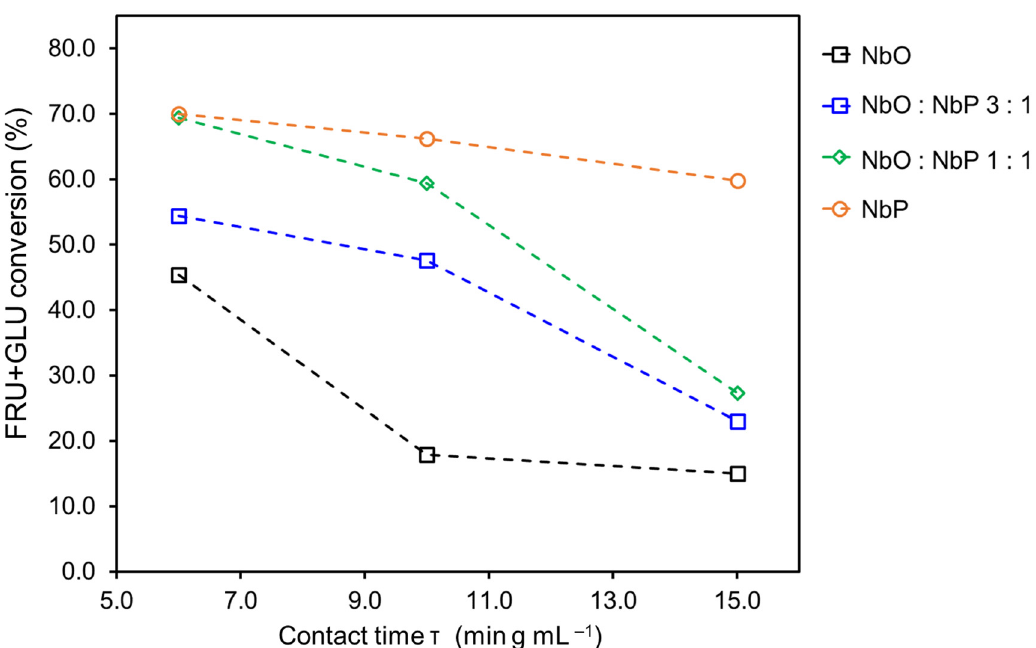
Figure 8. Trend of the conversion as a function of contact time in the continuous-flow reaction of glucose/fructose dehydration reaction (120 °C).